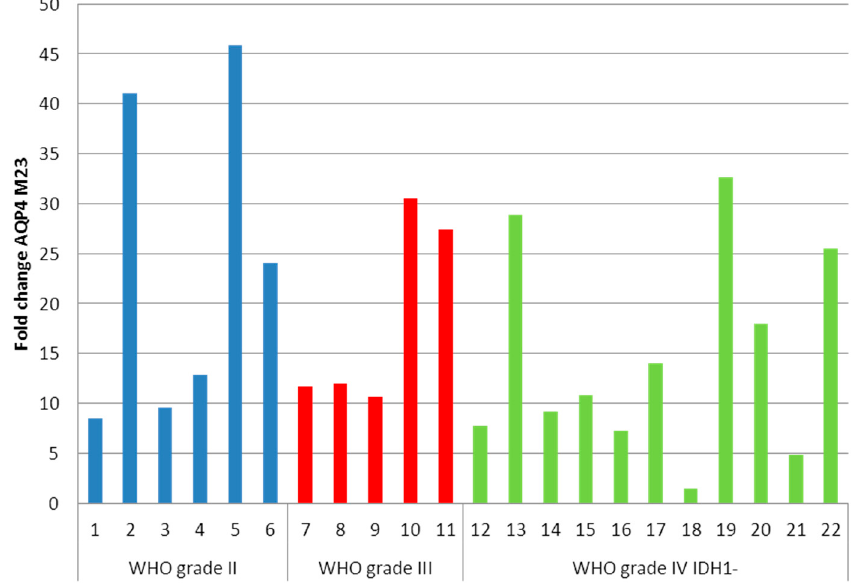
Figure 4. AQP4-M23 fold changes of astrocytomas. The average fold change is 17.93. No significant differences between the WHO grade groups were detected.